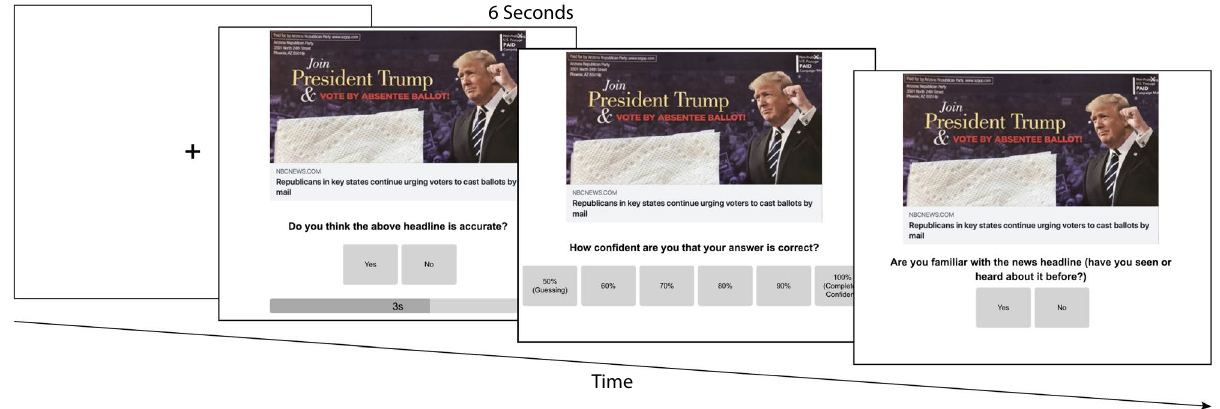
Figure 1. Screenshots from the time-pressure treatment. Each trial started with a fixation cross (1 s), followed by the veracity question that included a 6 s countdown timer, the confidence question, and the familiarity question. The control treatment was identical, except that there was no time limit (and no timer) for the veracity